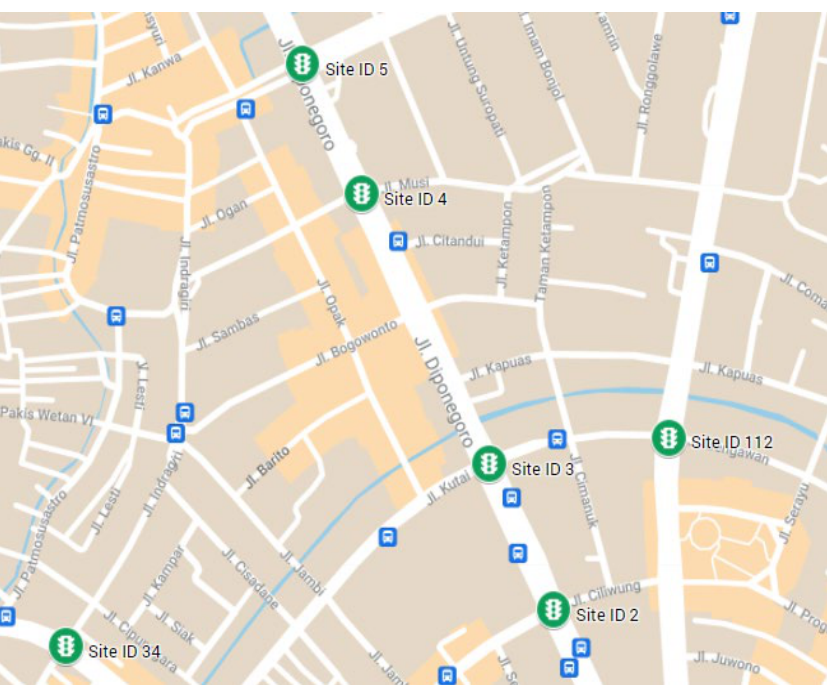
Figure 5. The Diponegoro neighborhood used in this paper as a case study. Each traffic light symbol represents a different intersection. Vehicle detectors in Diponegoro neighborhood consist of vehicle detectors in Site ID 2, Site ID 3, Site ID 4, and Site ID 5.